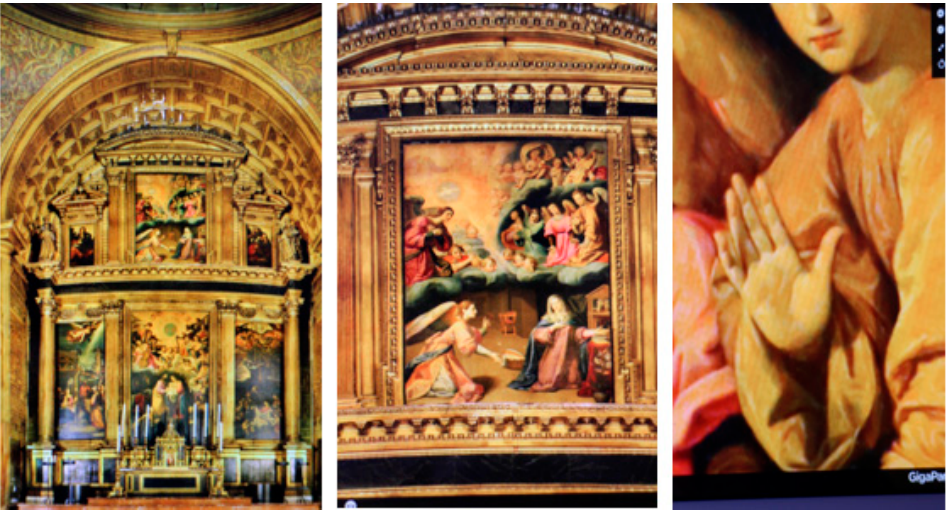
Figure 3. Image of the gigapixel of the artistic figure from the Annunciation. Source: developed by the authors.